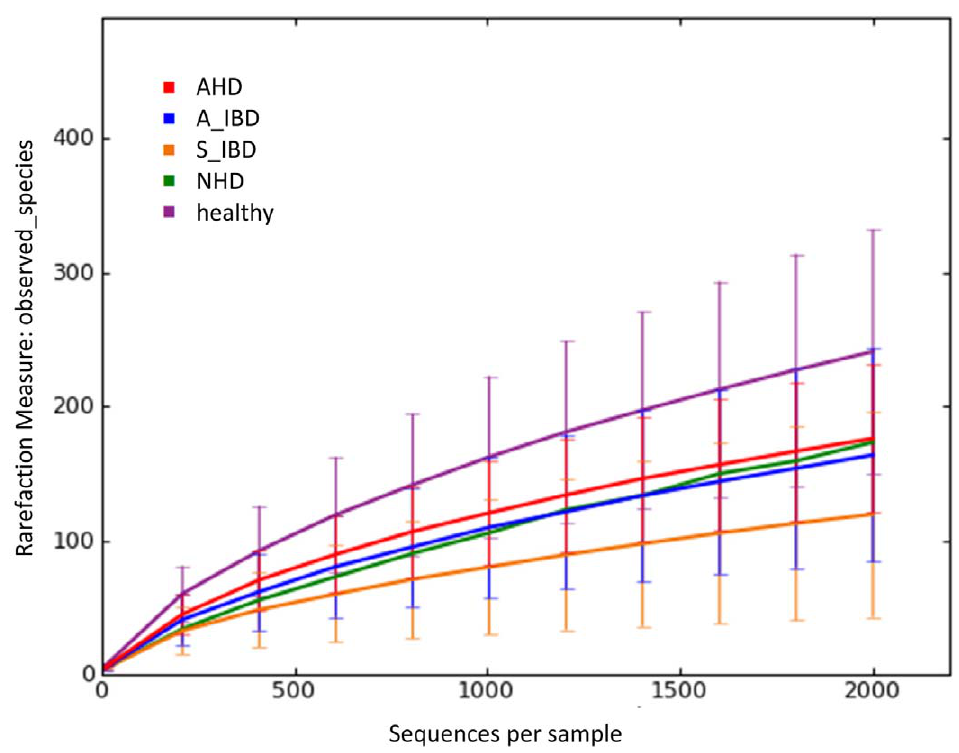
Figure 1. Rarefaction analysis of 16 S rRNA gene sequences obtained from canine fecal samples. Lines represent the average of each group, while the error bars represent the standard deviations. The analysis was performed on a randomly selected subset of 2,000 sequences per sample. A_IBD=active IBD; S_IBD=therapeutically controlled IBD; NHD=acute non-hemorrhagic diarrhea; AHD=acute hemorrhagic diarrhea.